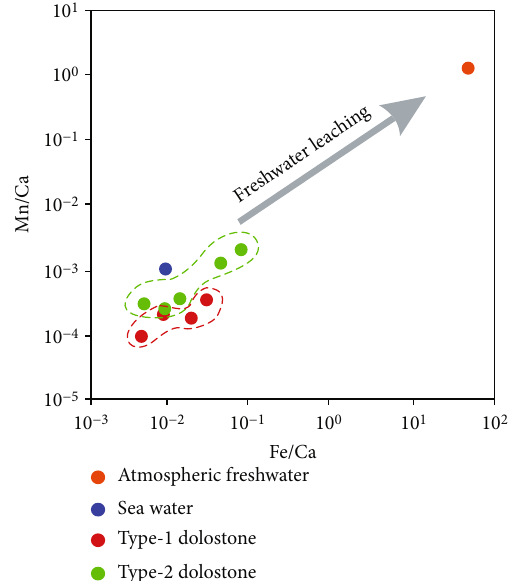
Figure 8: Plot of Mn/Ca versus Fe/Ca for submember Ma5